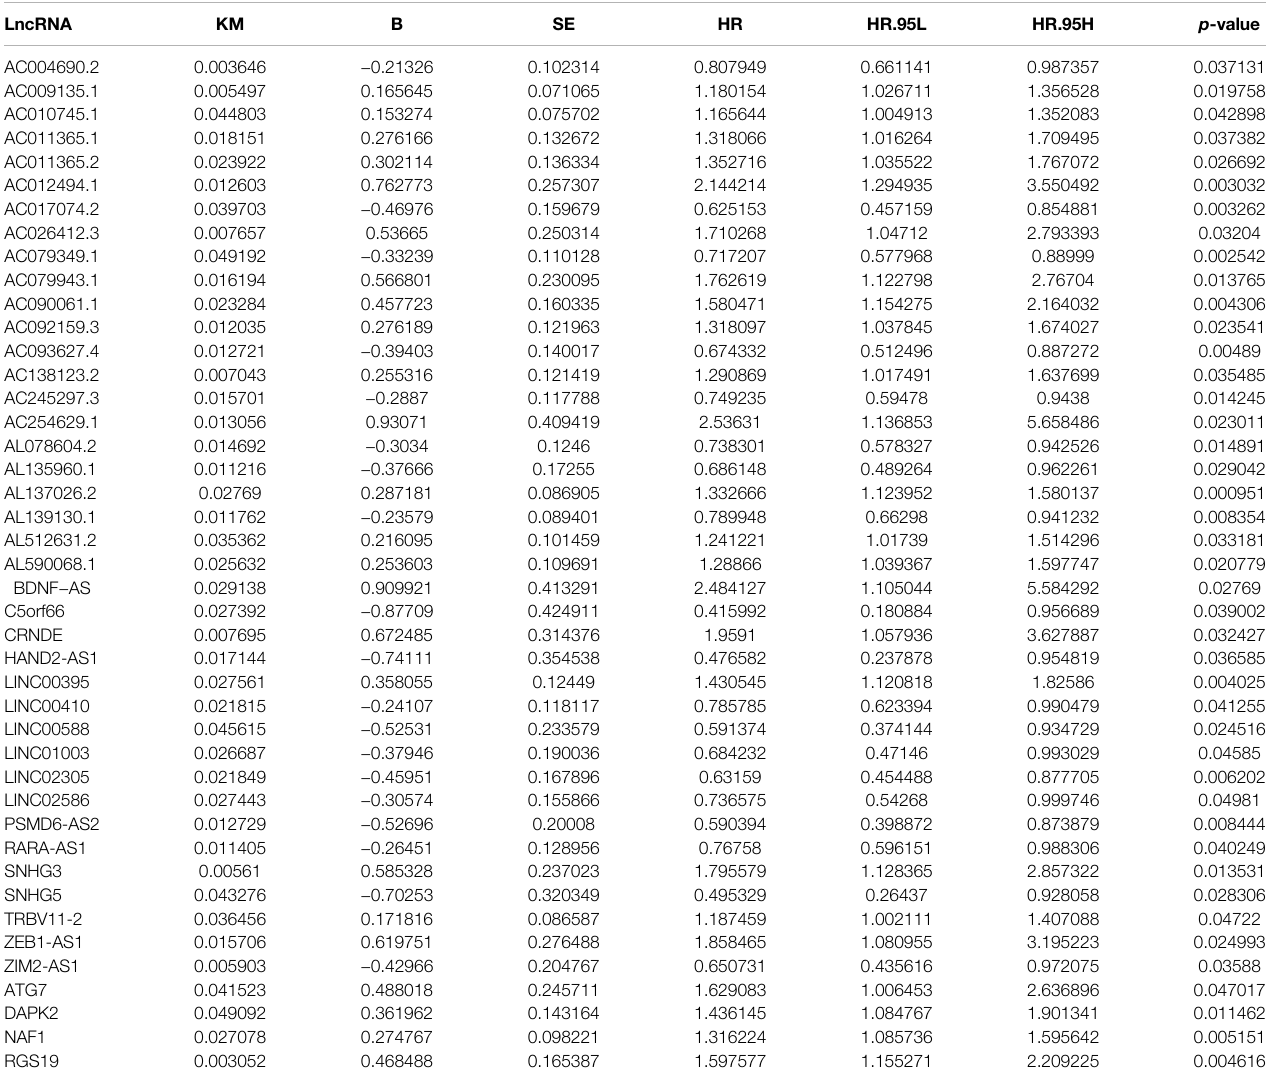
TABLE 1 | Signi fi cant prognostic autophagy lncRNAs in ESCC patients. LncRNA KM B